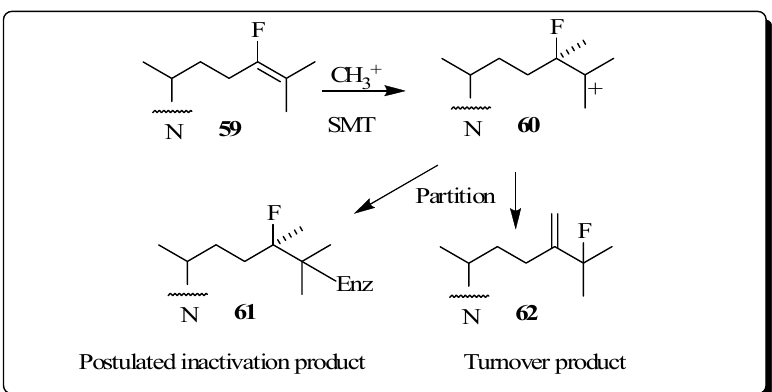
Figure 10. C24-methylation of 24-fluorocycloartenol by soybean